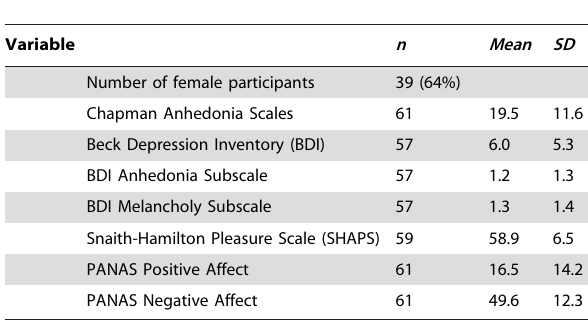
Table 3. Correlations between self-report measures and proportion of hard-task